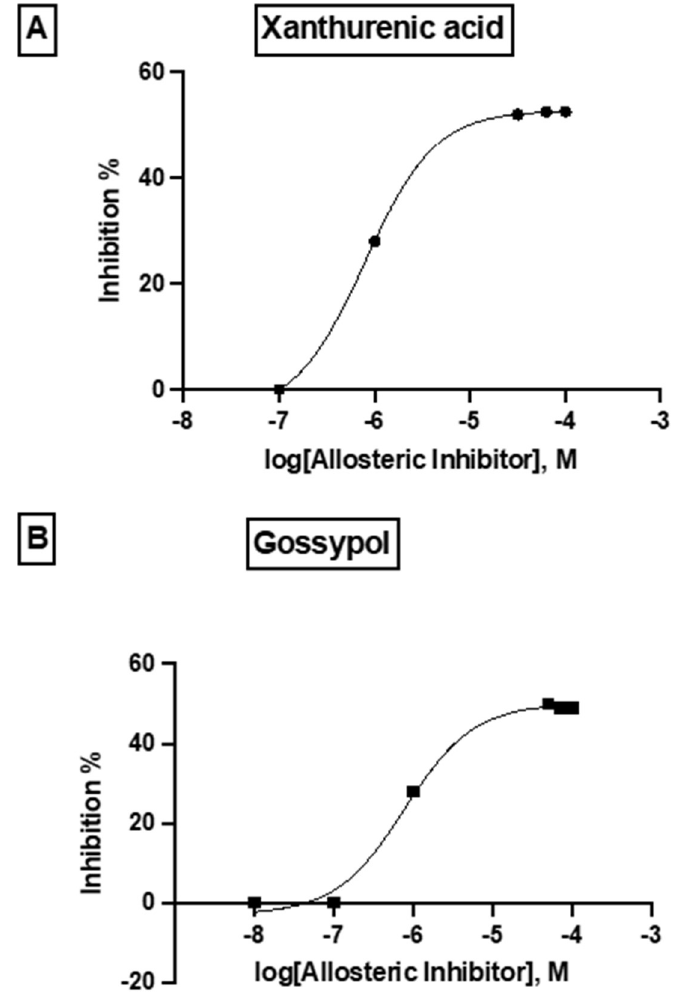
Figure 9. Dose–response curve of the allosteric metabolites xanthenuric acid and gossypol showing the log doses (x axis) versus % inhibition (y axis) in non linear regression.